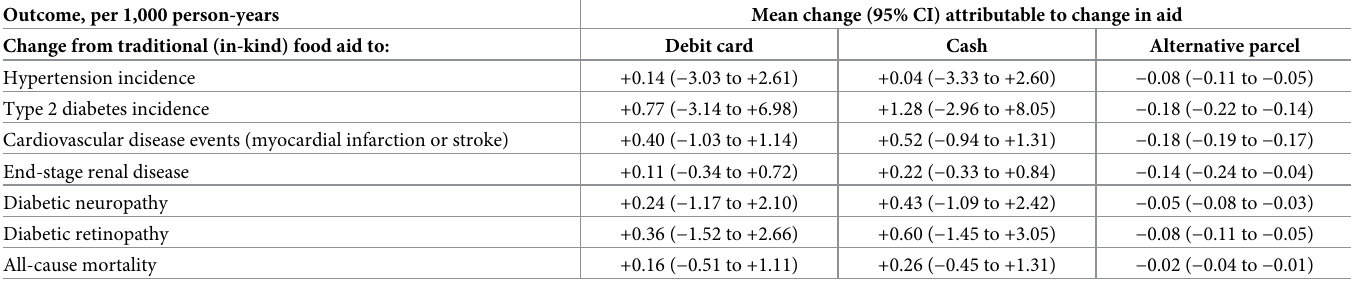
Table 5. Primary outcome estimates. Model-derived estimates of changes in chronic disease outcome measures attributable to a change from food parcel to electronic debit card delivery of food aid; a change from food parcel to cash aid; or a change from food parcel to alternative food parcel with less grain and increased fruit and vegeta- ble